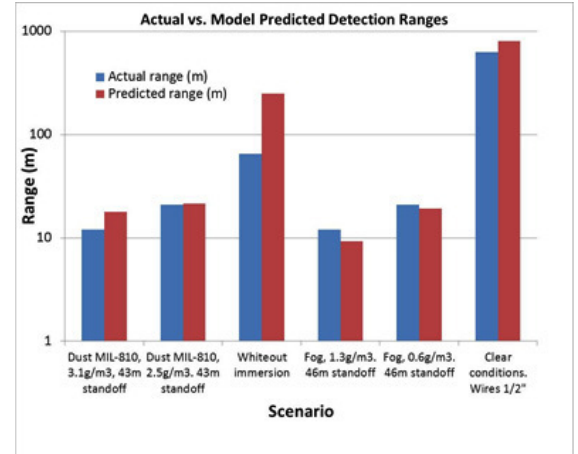
Figure 11: Comparison of predicted detection ranges in obscurants with measured detection